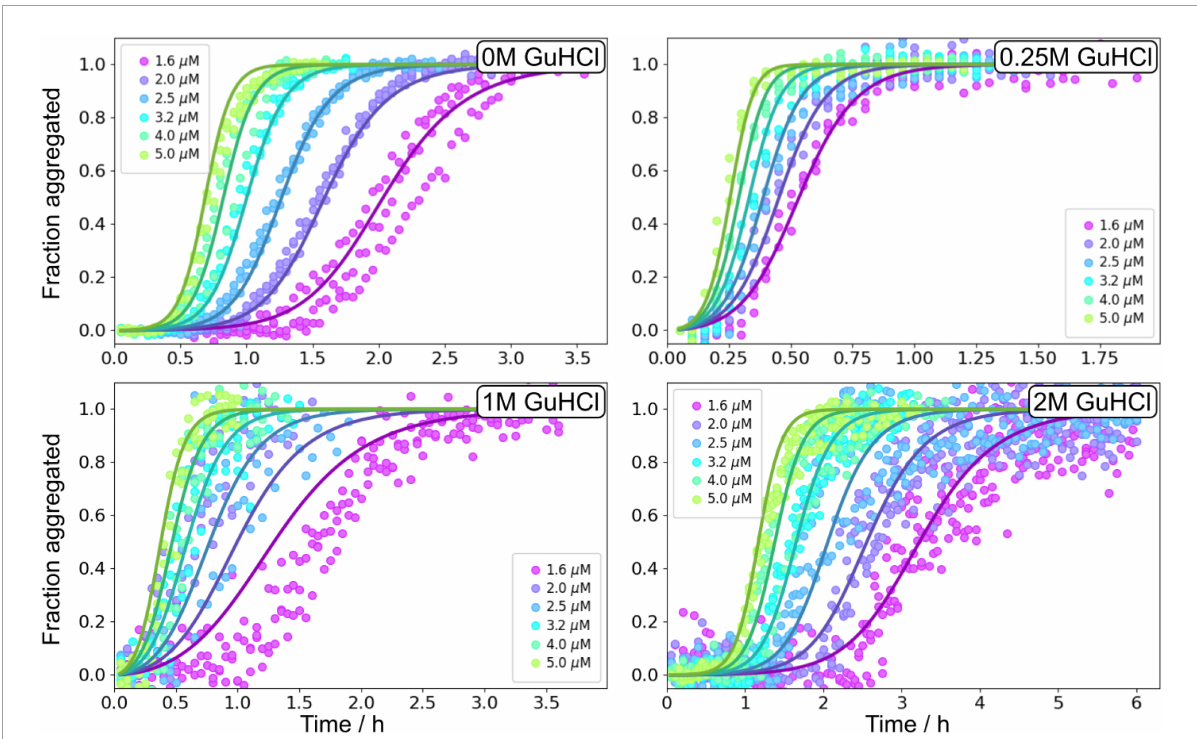
FIGURE7 Global fitting of A β 42 aggregation in GuHCl. A β 42 aggregation in the absence of GuHCl, at 0.25, 1, and 2 M GuHCl in 20 mM sodium phosphate, 0.2 mM EDTA, 0.02% sodium azide, pH 8.0 were fitted with a model describing secondary nucleation as a multistep event, see Equation 5. Additional globally fitted data set is shown in Supplementary Figure 10